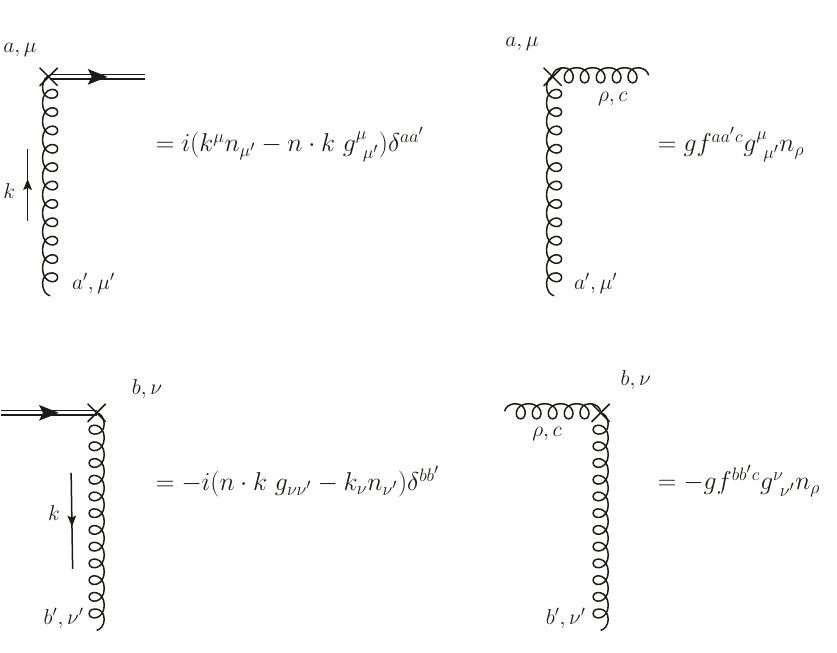
Figure 1 . The Feynman rules for non-local vertex from gluonium operator. The left two sub- diagrams are from the Abelian part of the gluon field strength tensor, while the right two are from the non-Abelian part.